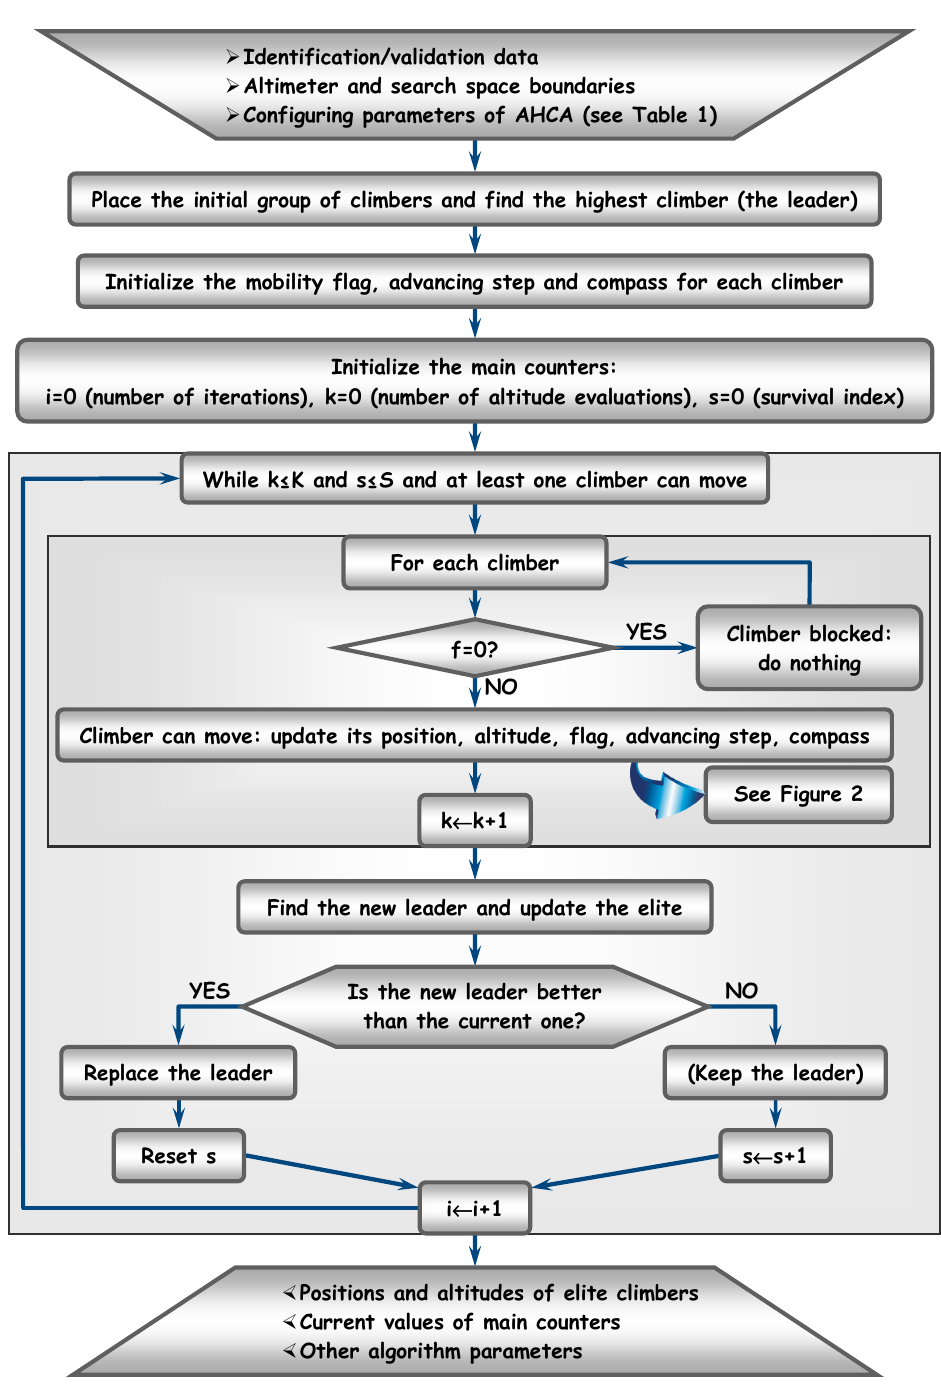
Figure 1. Flow diagram of the Advanced Hill Climbing Algorithm (AHCA).